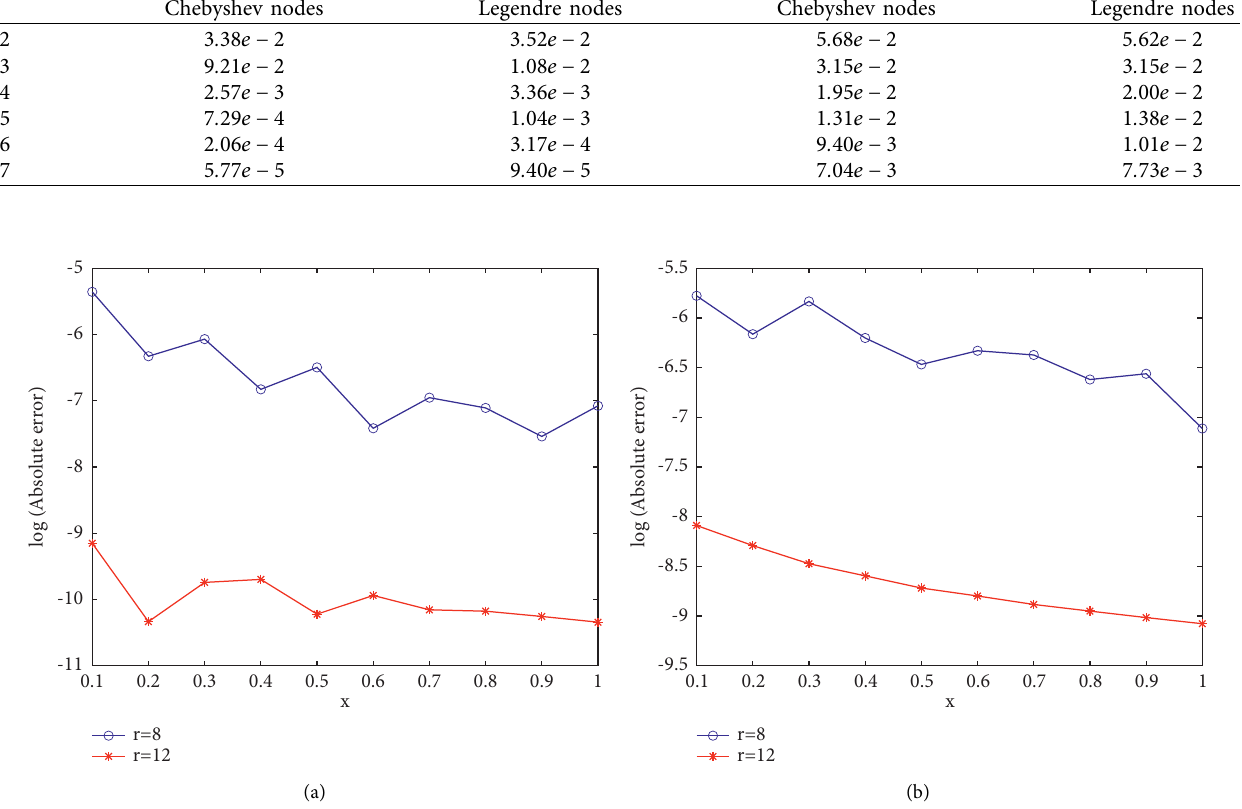
Figure 3: Plot of the absolute error at the Chebyshev nodes (a) and the Legendre nodes (b) taking different r for Example